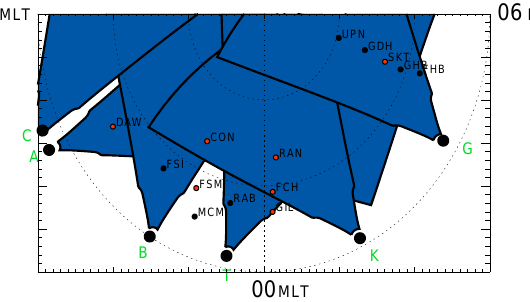
Fig. 2. Fields-of-view of the Northern Hemisphere SuperDARN radars at 07:00UT, the centre time of the main interval considered in this paper. These are plotted on a geomagnetic grid with the pole at the top and dusk to the left, down to 60 ◦ . Also shown are ground-based magnetometer locations, with red dots indicating sta- tions whose data has been explicitly shown in this